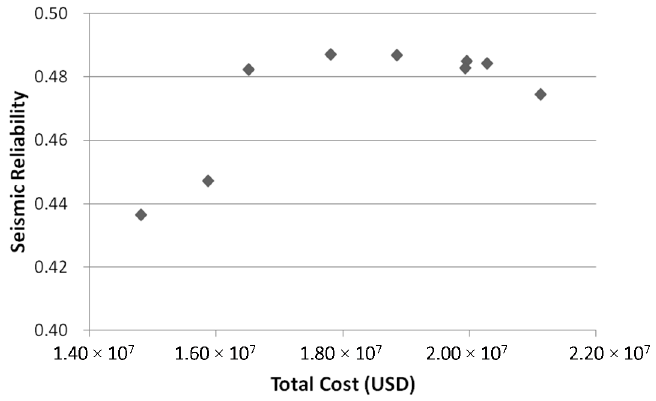
Figure 7. Trade-off relationship between total cost and seismic reliability in Case 1 where all pipes (152, 203, 254, 305, 356, 406, 457, 508, 610, and 762 mm) are available and without zero pipe option.